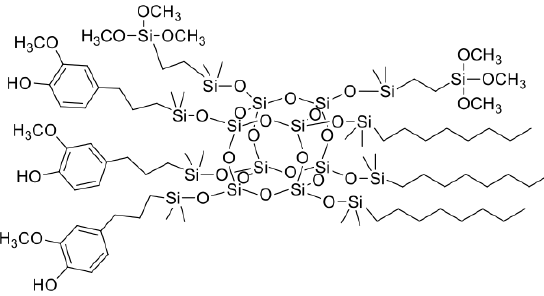
Figure 4. The chemical structure of SSQ4.